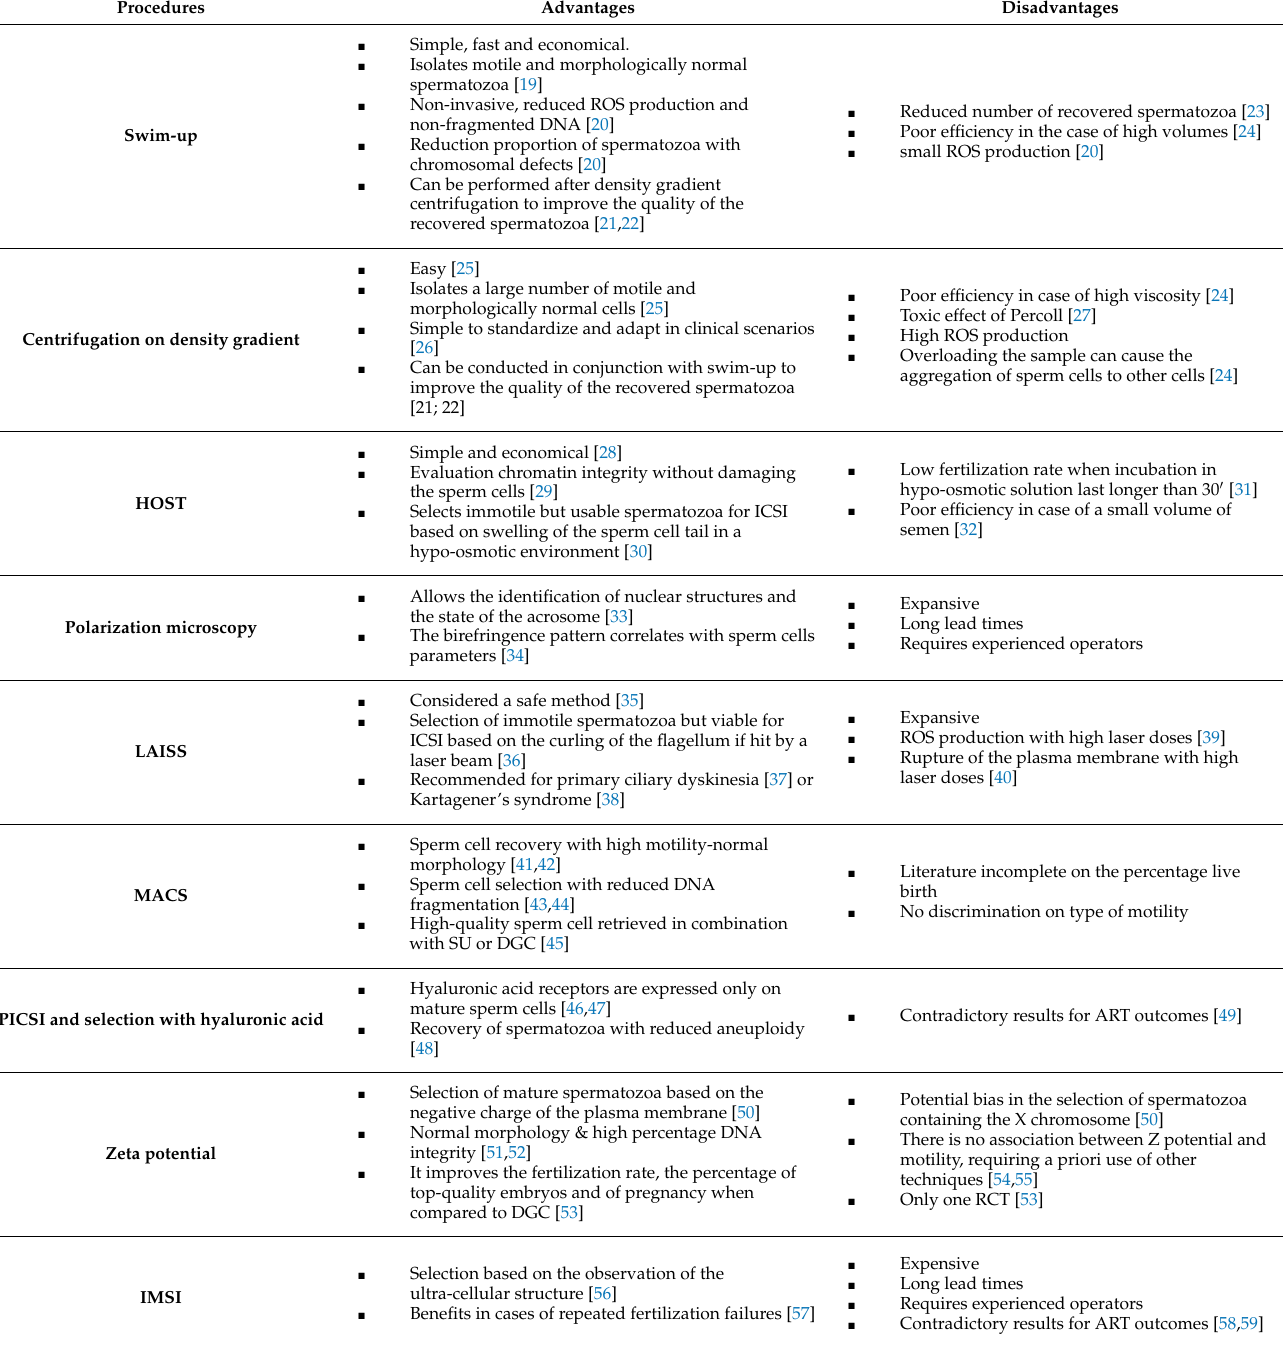
Table 1. Advantages and disadvantages of sperm cells’ selection